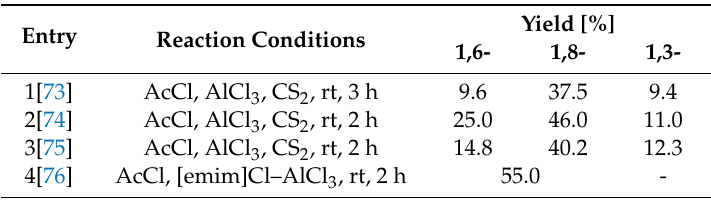
Table 3. Reported conditions of acylation reaction.